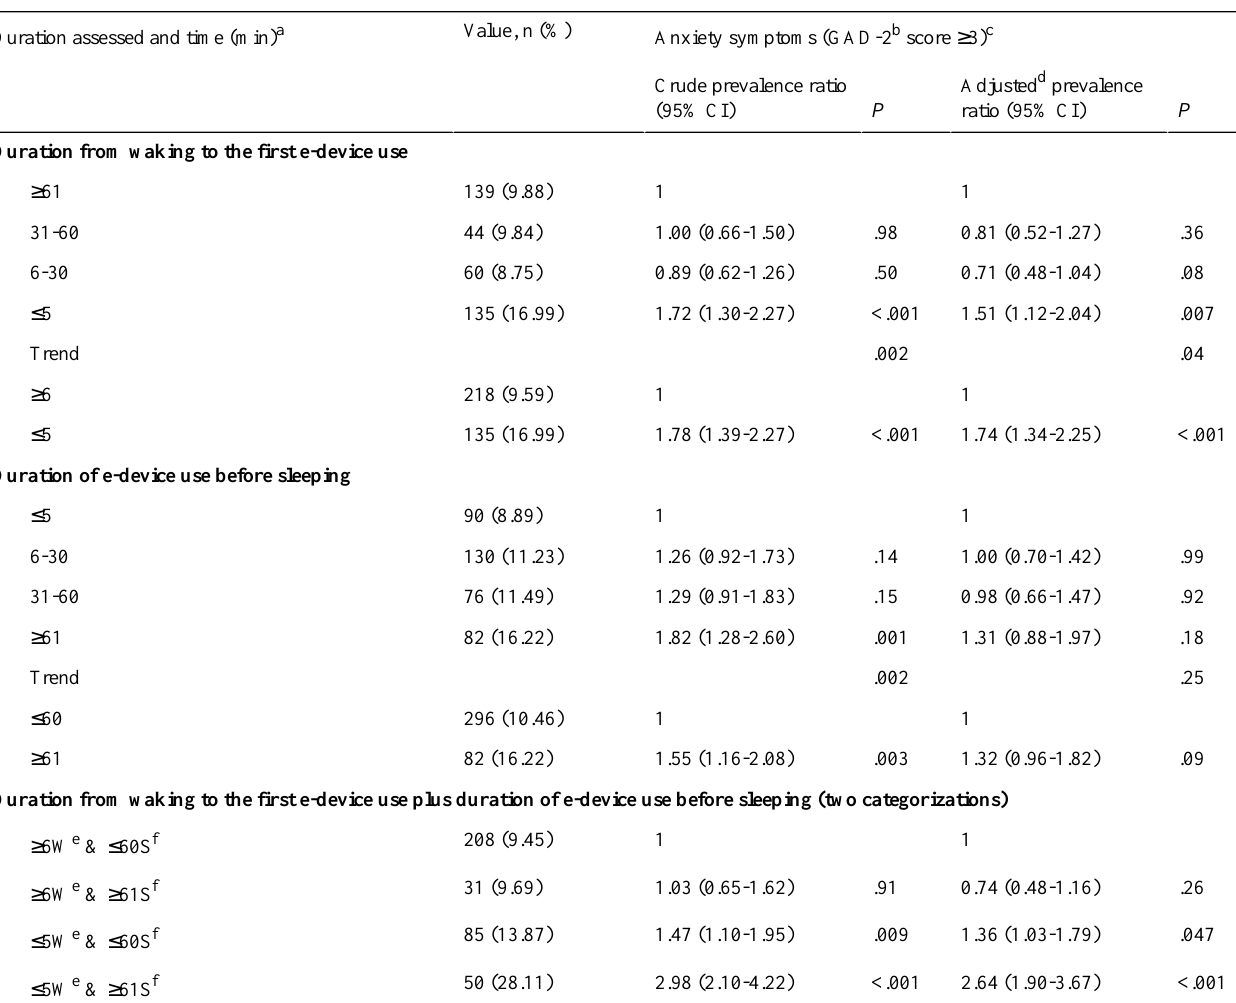
Table 4. Poisson regression of anxiety symptoms for the duration from waking to the first e-device use and duration of e-device use before